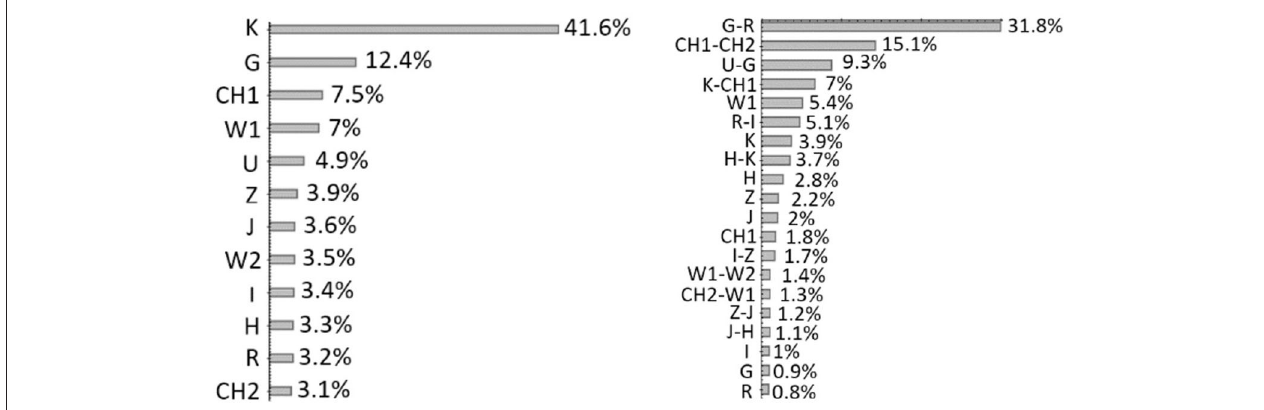
FIGURE 9 | Figure from Brescia et al. (2019). (Left) Results of the feature analysis performed with 8 LAB. The importance of each feature is estimated for the case in which only magnitudes are considered for the sample. (Right) The case in which a mixed parameter space (magnitudes and colors) is